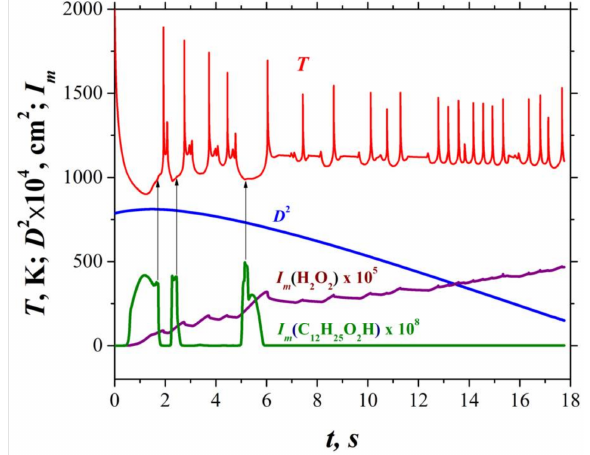
Figure 13. Calculated time histories of the integral mass fractions I m (C 12 H 25 O 2 H) and I m (H 2 O 2 ) as well as the maximum gas temperature, T m , and the squared droplet diameter, D 2 , at the forced ignition and combustion of the n-dodecane droplet with D 0 = 2.8 mm and L = 0.55 cm in air at NPT conditions. Arrows mark the instants of C 12 H 25 O 2 H decomposition.